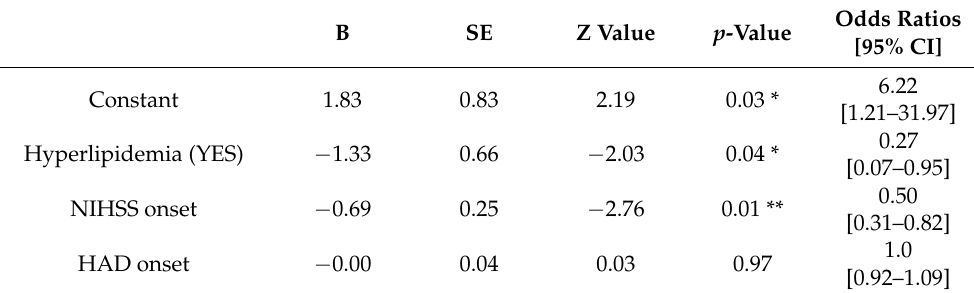
Figure 2. Odds ratio related to the binary logistic regression model. The “ ↑ ” symbol represents high scores such that, for e.g., high NIHSS scores at onset will favour NoRTpW. The blue circle represents the odds ratio and the grey bars the 95% confidence intervals. Table 2. Factors associated with returning or not to paid work at 3